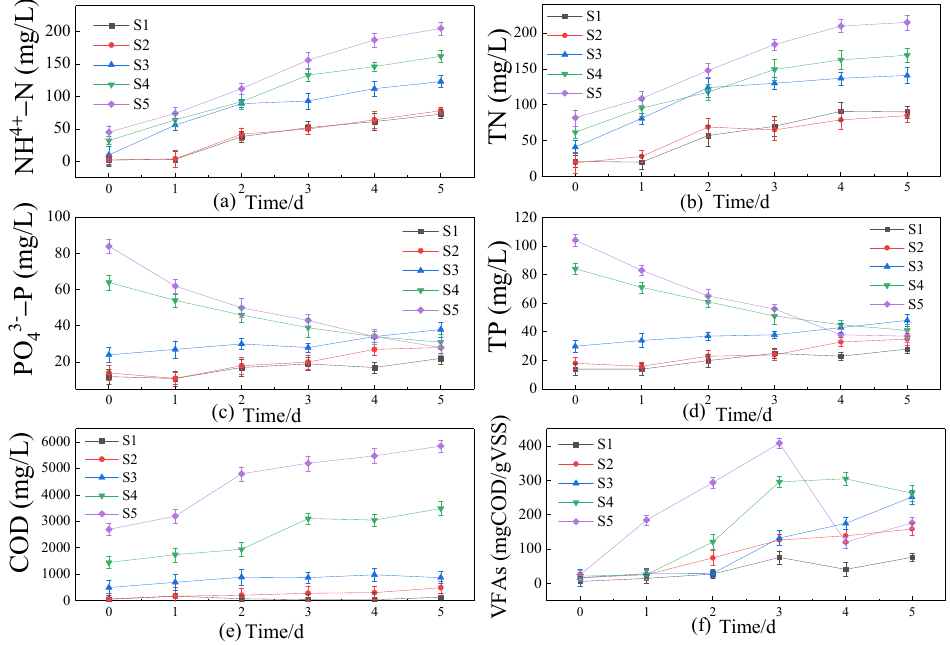
Figure 2. Variation of liquid pollutant concentration with digestion time (( a ), ( b ), ( c ), ( d ), ( e ) and ( f ), respectively, are the changes of NH 4+ -N, TN, PO 43 − -P, TP, COD and VFAs concentrations during 5 days).